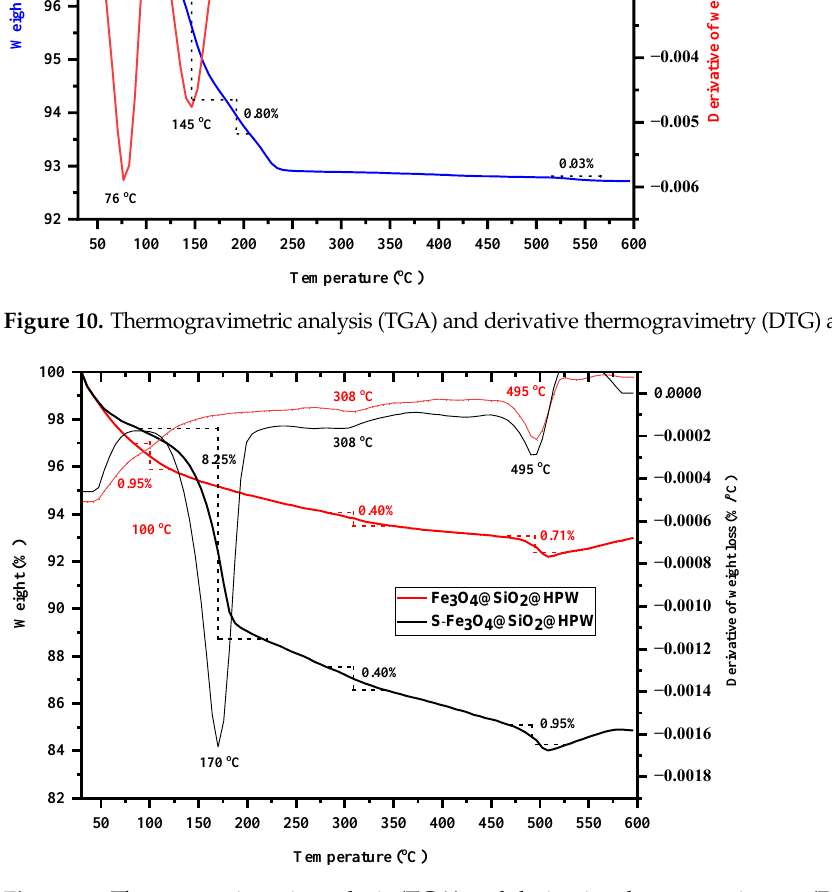
Figure 11. Thermogravimetric analysis (TGA) and derivative thermogravimetry (DTG) analysis of